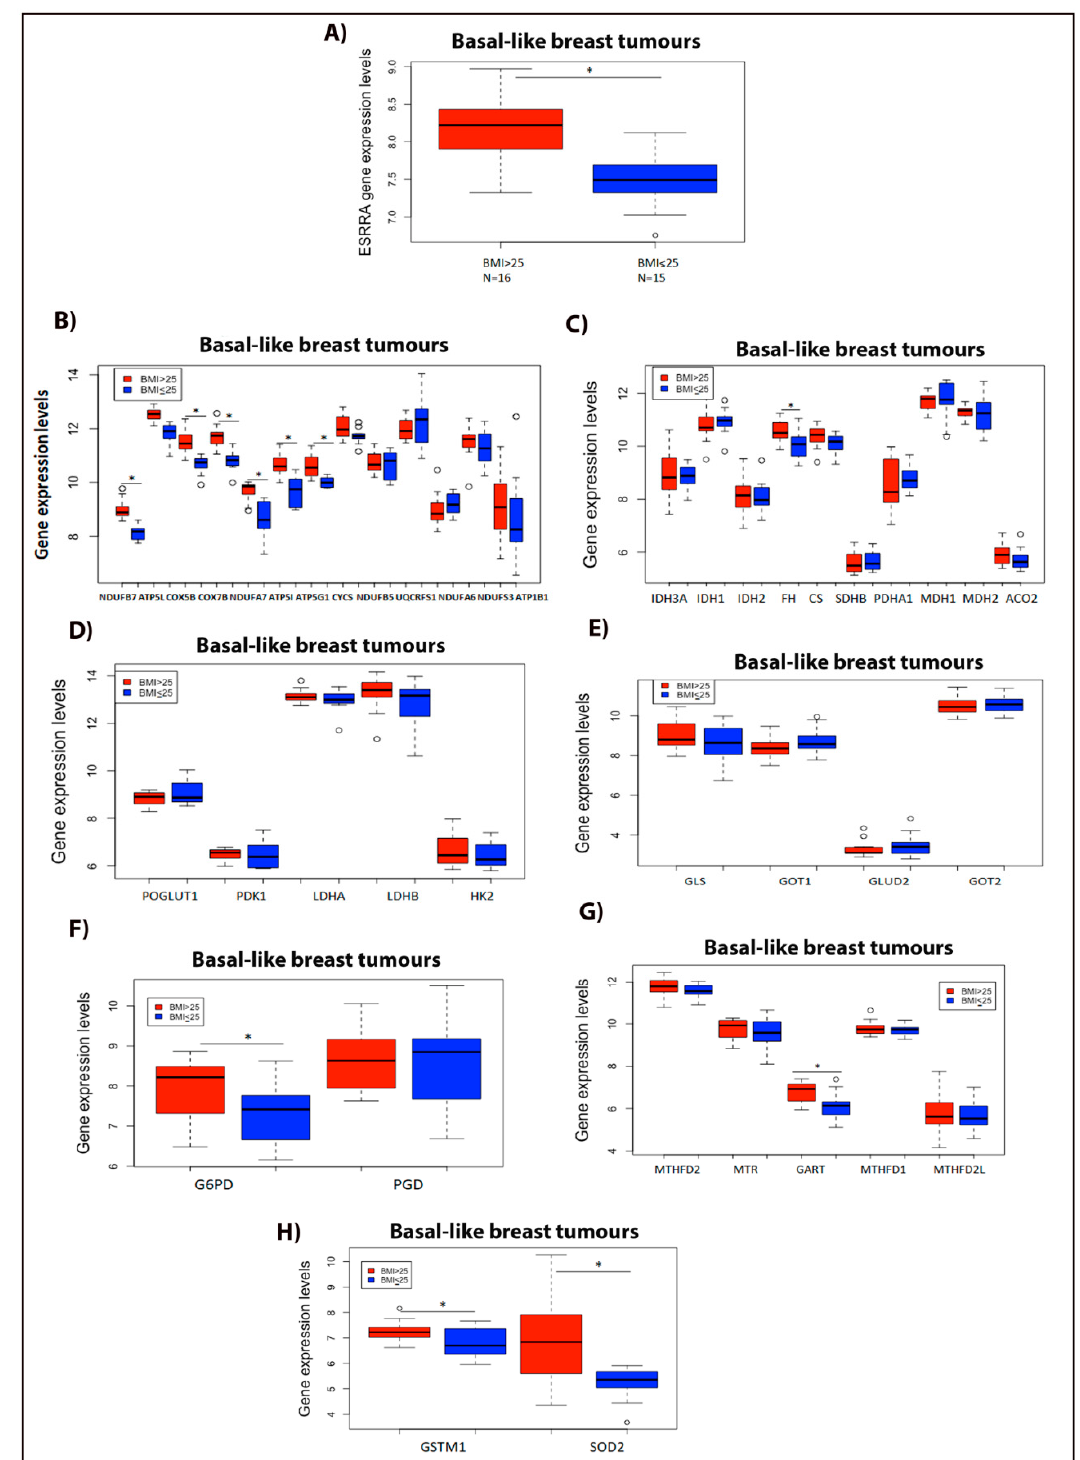
Figure 7. ERR α metabolic gene signature profile increases in basal-like breast tumours of overweight/obese vs. lean patients. ( A ) ESRRA gene expression levels in overweight/obese breast cancer patients with BMI > 25 ( N = 16) vs. lean patients with BMI ≤ 25 ( N = 15). ( B ) ERR α metabolic target genes involved in the OXPHOS pathway. ( C ) ERR α metabolic target genes associated with the TCA cycle. ( D ) ERR α metabolic target genes linked to the glycolytic pathway. ( E ) ERR α metabolic target genes related to the glutaminolysis pathway. ( F ) Gene expression levels involved in PPP intermediates. ( G ) ERR α metabolic target genes associated with the OCM pathway. ( H ) ERR α metabolic target genes involved in detoxifying enzymes. These data were obtained from the GEO: GSE78958 study, and were analyzed using R software (version 4.0.2, R core team, Vienna, Austria). For all the above panels, the number of patients in the BMI > 25 group is N = 16, and for the